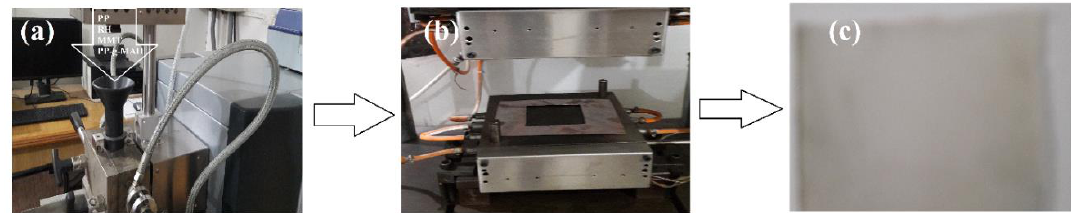
Figure 1. A schematic of the composite sheet fabrication process: ( a ) melt compounding in an internal mixer, ( b ) compression molding, and ( c ) compression-molded film sample for testing.